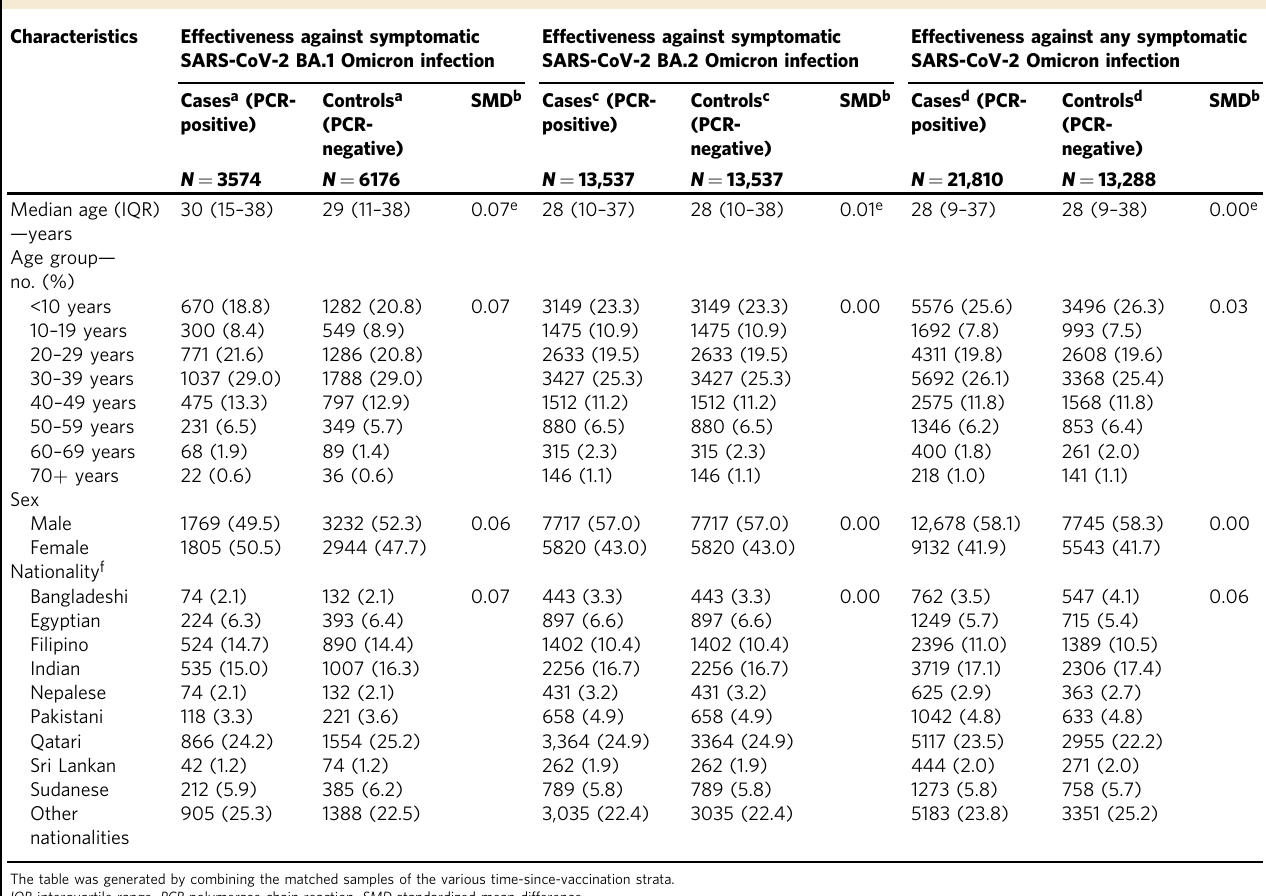
Table 2 Demographic characteristics of cases and controls in samples used to estimate effectiveness of the mRNA-1273 vaccine against symptomatic SARS-CoV-2 BA.1 Omicron infection, symptomatic BA.2 Omicron infection, and any symptomatic Omicron infection.